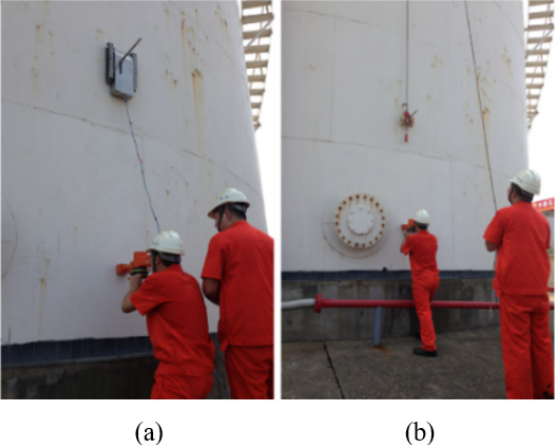
Figure 15. External Measurement progress with ( a ) a TWCR and ( b ) trolley.